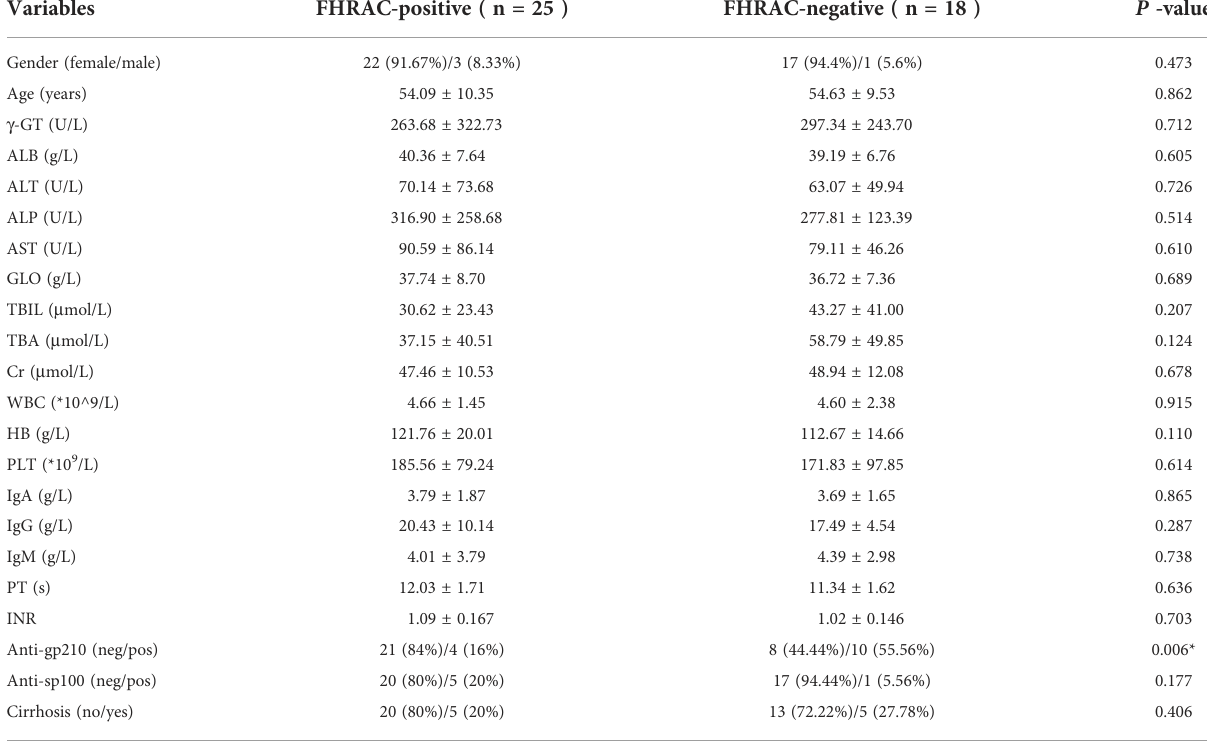
TABLE 1 The baseline characteristics of PBC in FHRAC-positive and FHRAC-negative groups.